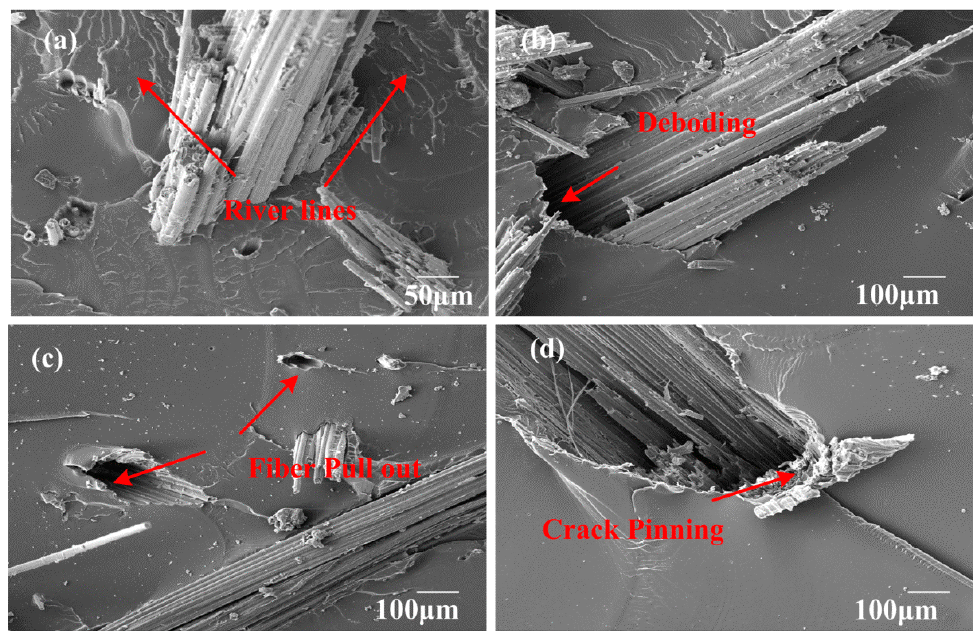
Figure 19. SEM images of composites with fiber length of 15 mm.